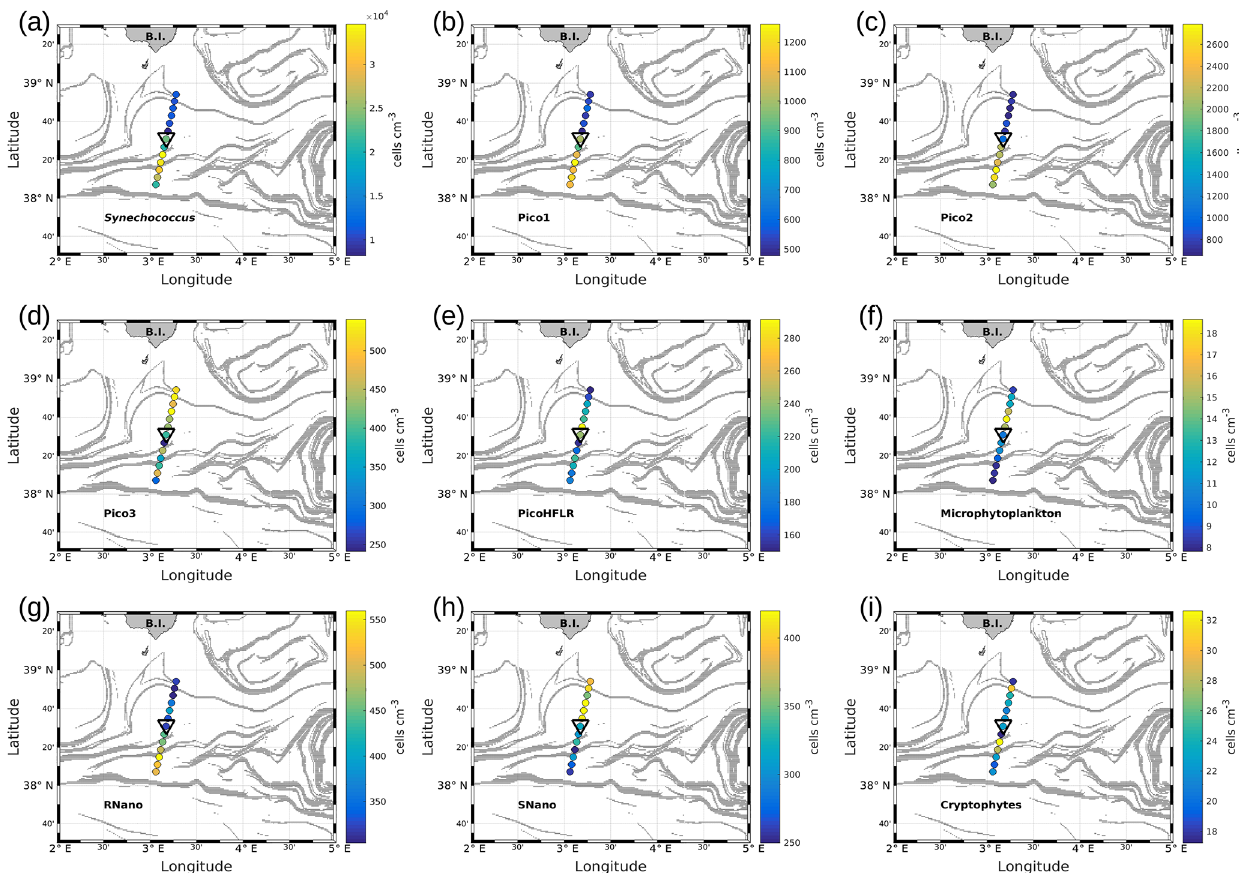
Figure 8. As in Fig. 7 but for the NS